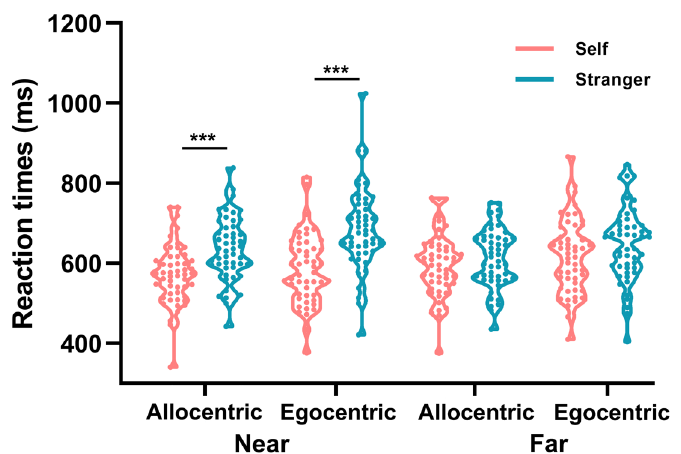
Figure 1. Mean reaction times in spatial reference frame tasks. The RT of the self-association group was faster than that of the stranger-association group ( p = 0.001). Additionally, the RT of the allocentric judgment task in near space (571 ms) was faster than that of the egocentric judgment task in far space (617 ms) in the self- association group ( p < 0.001). The RT of the allocentric judgment task was faster than that of the egocentric judgment task ( p < 0.001). A significant interaction effect was found among groups, spatial domains, and reference frame judgment tasks. Specifically, in near space, the reaction times of allocentric representation in the self-association group (571 ms) were faster than those in the stranger-association group (636 ms) ( p < 0.001), and the reaction times of egocentric judgment tasks in the self-association group (587 ms) were faster than those in the stranger-association group (685 ms) ( p < 0.001). No difference was found in egocentric or allocentric judgment tasks between the groups in far space ( ps >